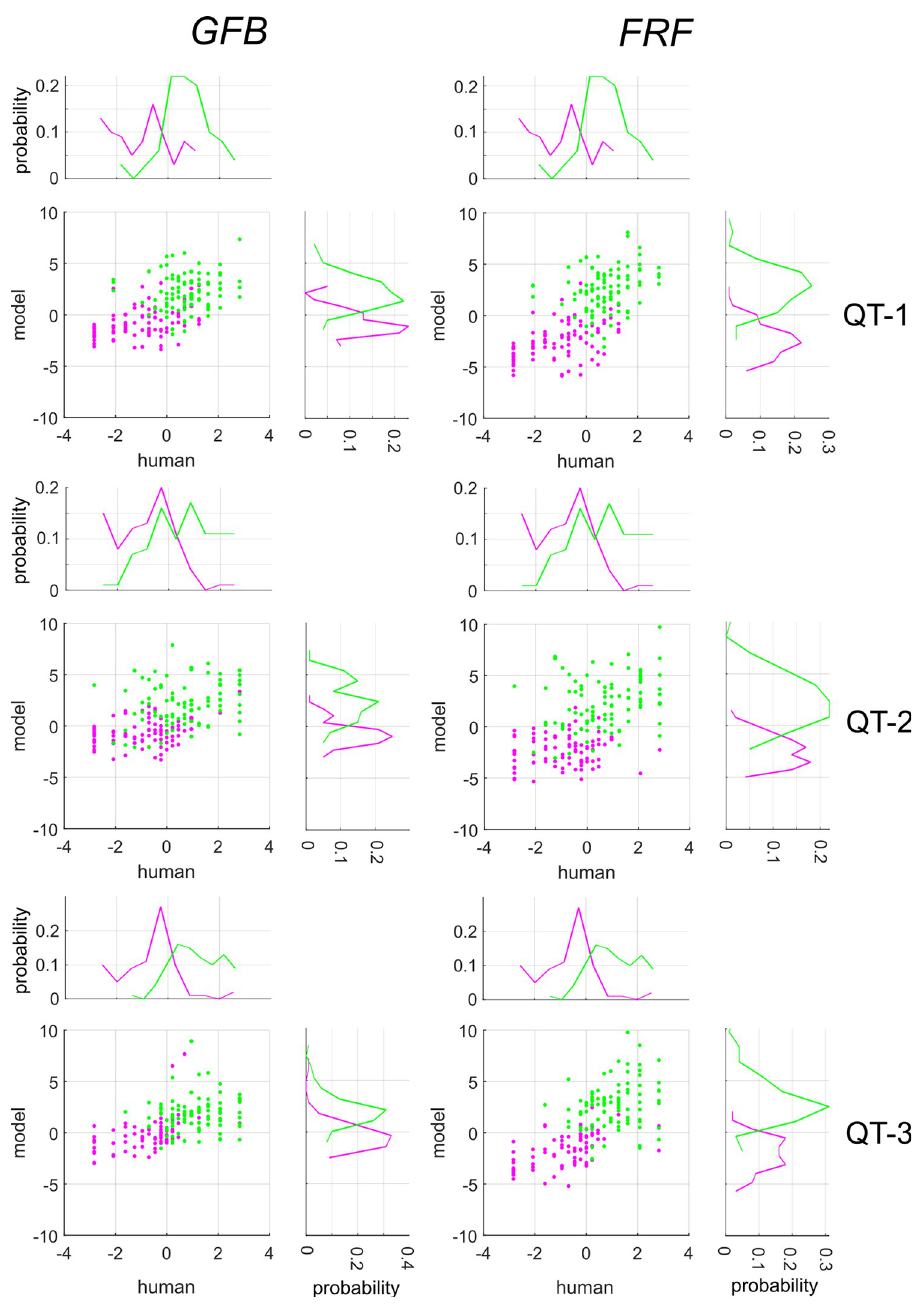
Fig 12. Log-odds ratios of human observers (AO, horizontal axes) and GFB, FRF models (vertical axes) for each image for all three surveys. Magenta symbols indicate image patches that are shadows, green symbols indicate occlusions. On the margins of each scatterplot we show the distributions of the log-odds ratios for each image